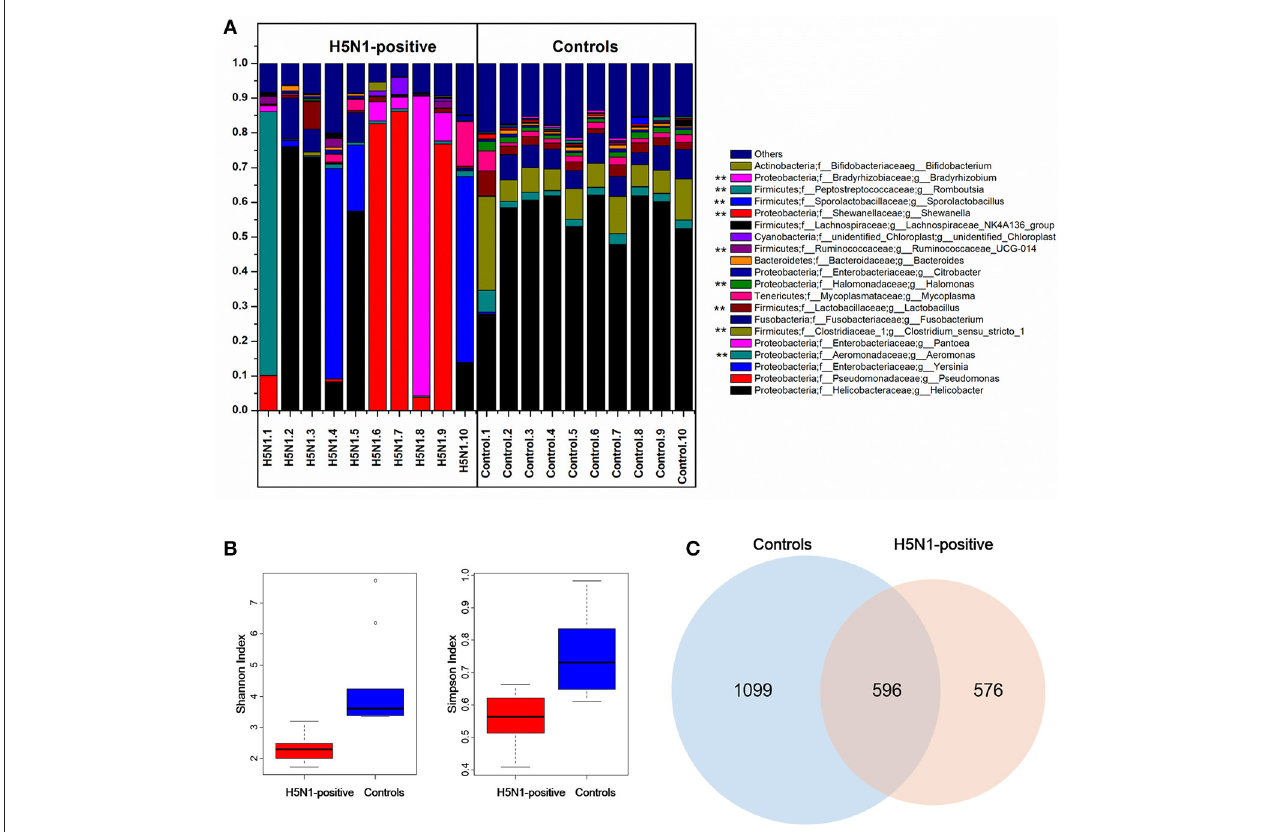
FIGURE 2 | Comparison of the composition of fecal microbiota between H5N1-infected whooper swans and healthy controls. (A) Relative contribution of the top 20 dominant genera in each sample. Genera that differed significantly between the H5N1-infected individuals and the healthy controls are marked with stars (** p < 0.01 using Mann-Whitney U -test). The Shannon and Simpson (B) indices were used to estimate diversity (data shown as the mean ± SEM). Venn diagram illustrating overlap of OTUs in fecal microbiota between the individuals with or without H5N1 infection (C)